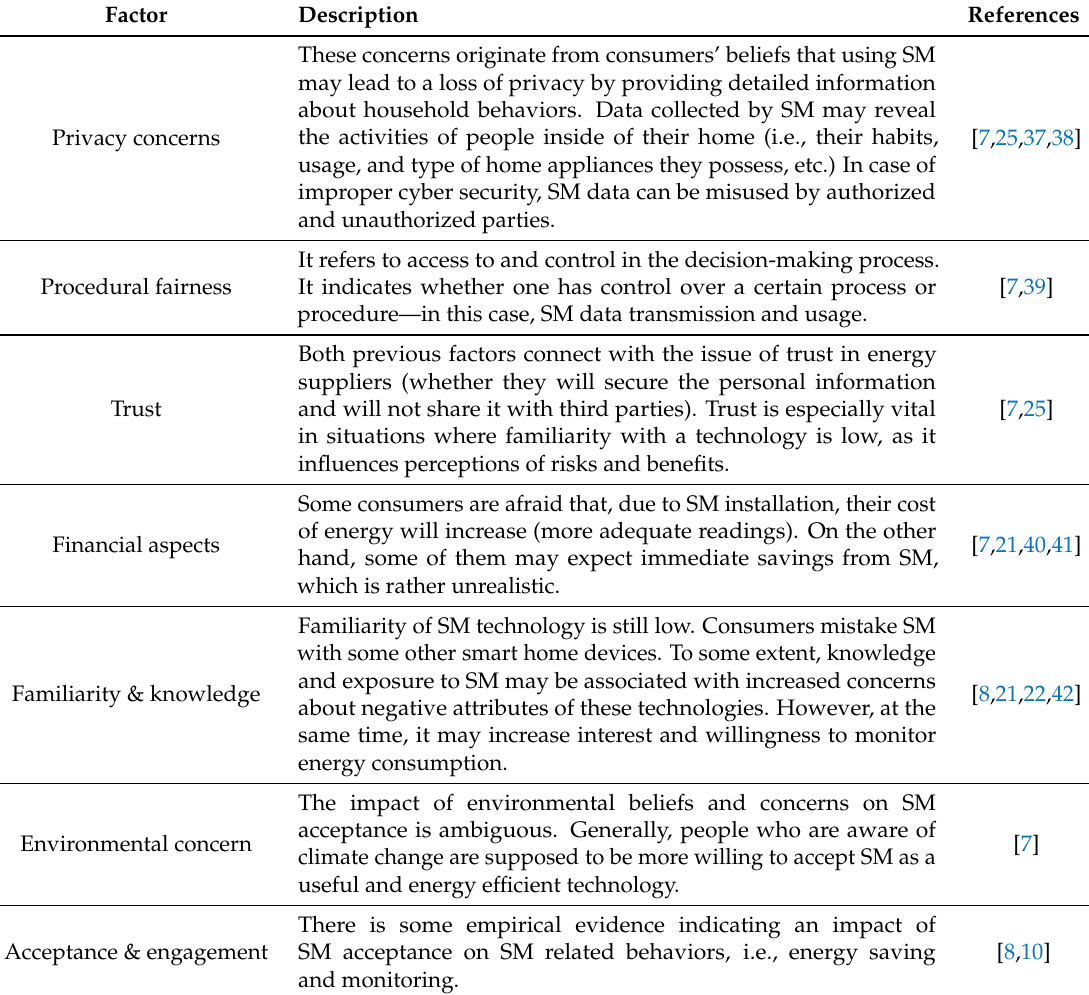
Table 1. Incentives and barriers of SM and SMP